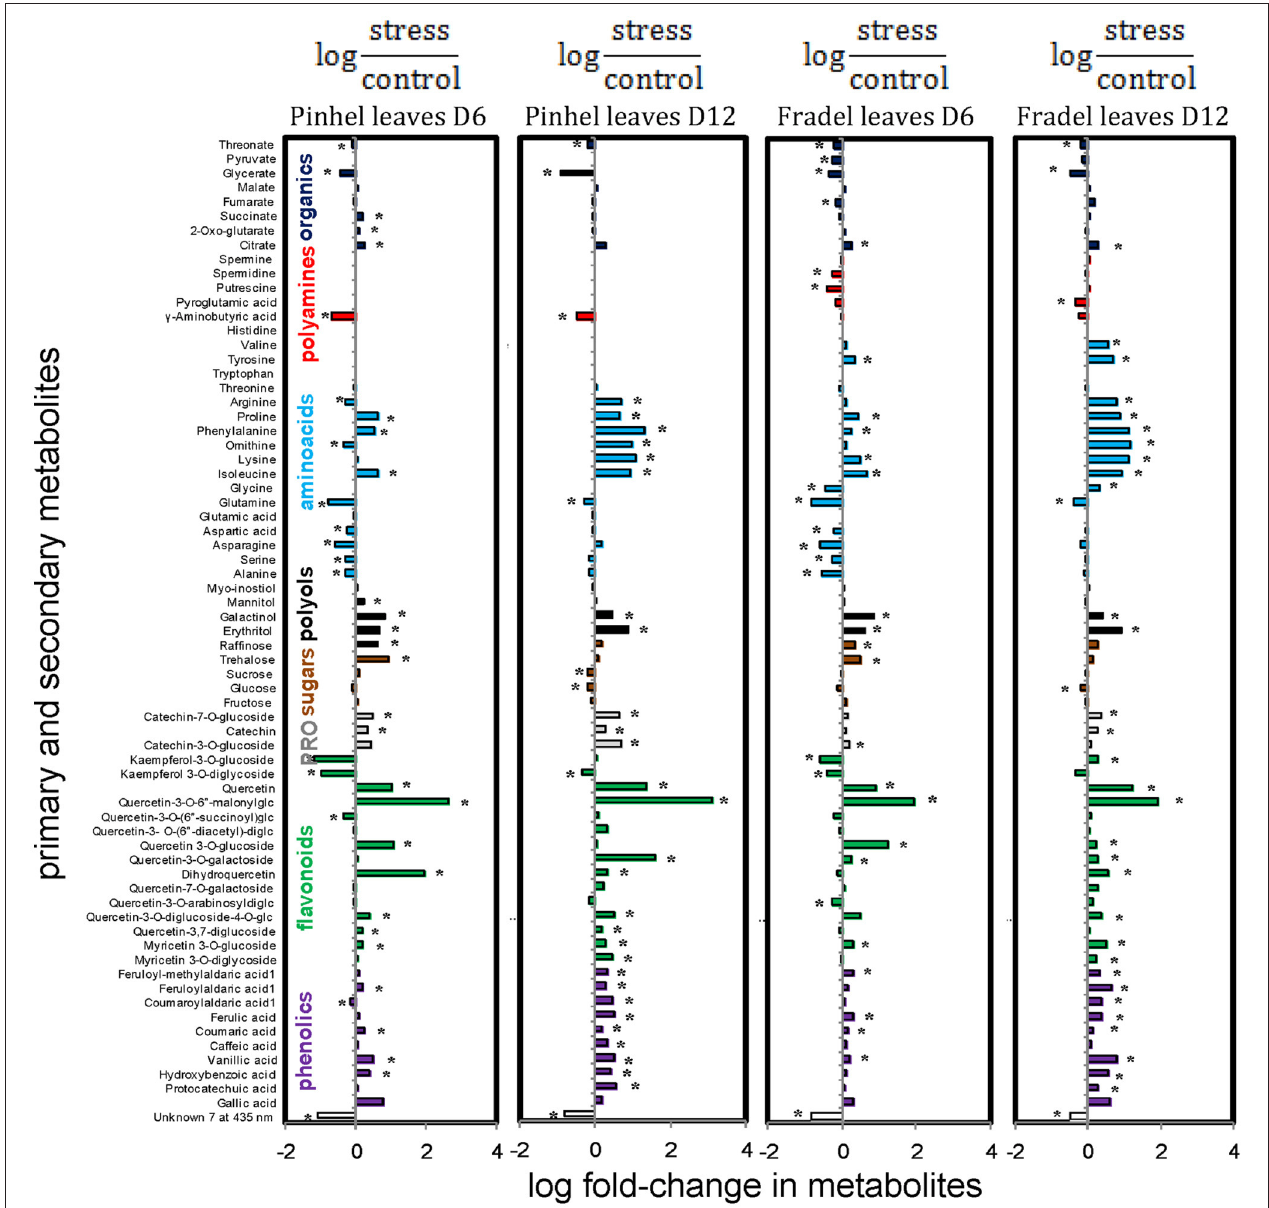
FIGURE 9 | Effects of drought stress on cowpea leaf metabolites. Data are presented as averaged logarithmic fold-change ratios of metabolite levels in drought-stressed and control plants. Unidentified and undetected metabolites (with the exception of Unknown 7) are omitted for visual clarity. PRO = proanthocyanidins. Measurements were taken on day 6 (D6) or 12 (D12) of water stress ( n = 4–6). Responses are represented by bars that indicate increased levels in drought-stressed plants (positive values) or decreased levels (negative values). Asterisks indicate values that were determined to be statistically different using t -tests ( P <